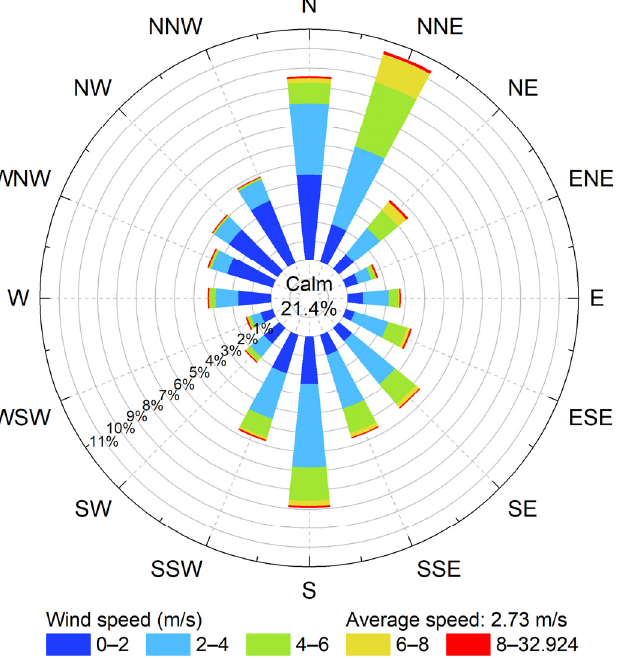
Figure 4. Annual wind rose of Singapore.